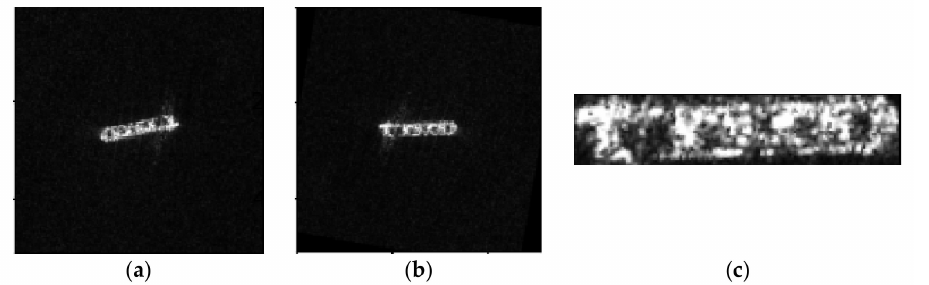
Figure 4. Rotation maximum projection (RMP). ( a ) An original SAR ship image; ( b ) an rotated SAR ship image with a maximum projection in x -direction; ( c ) the minimum bounding